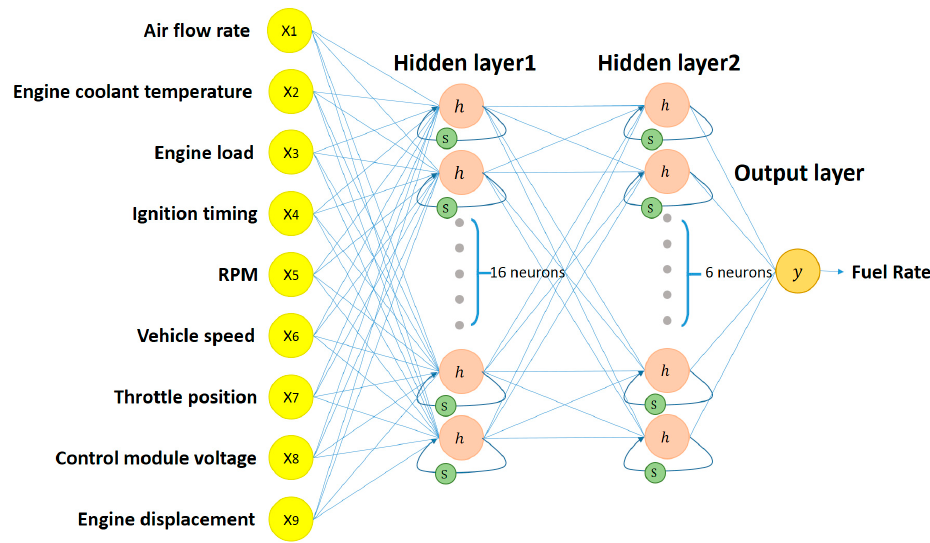
Figure 7. The proposed structure of Elman neural network.